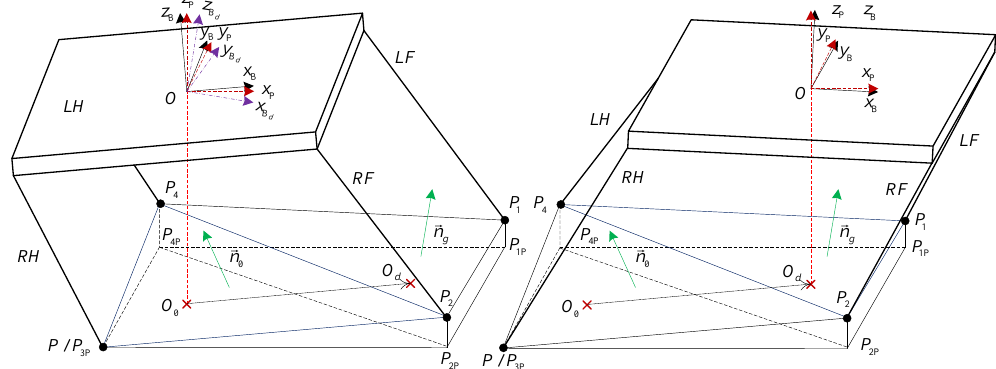
Figure 7. Attitude-position adjustment